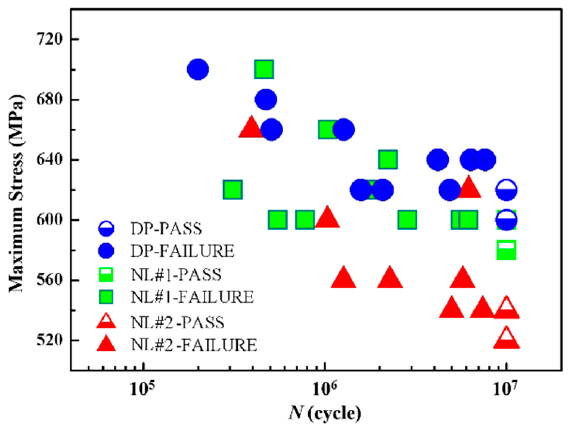
Figure 4. S - N data of different TiAl alloys.